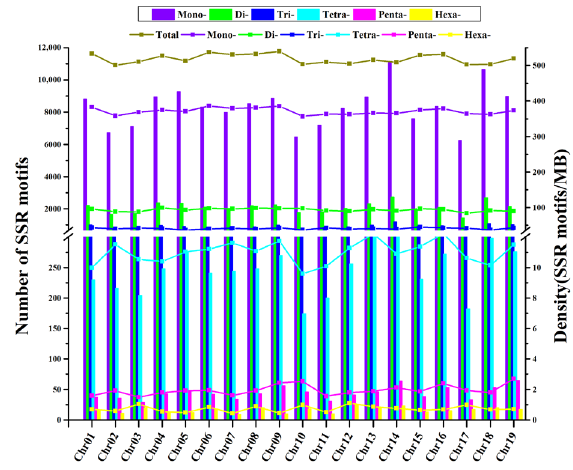
Figure 1. Overall view of the motif distribution of SSRs and SNP density in the genome of nineteen ‘PN40024’ chromosomes (chr1–chr19) was assembled by Hi-C. ( a ) SSR; ( b ) SNP.